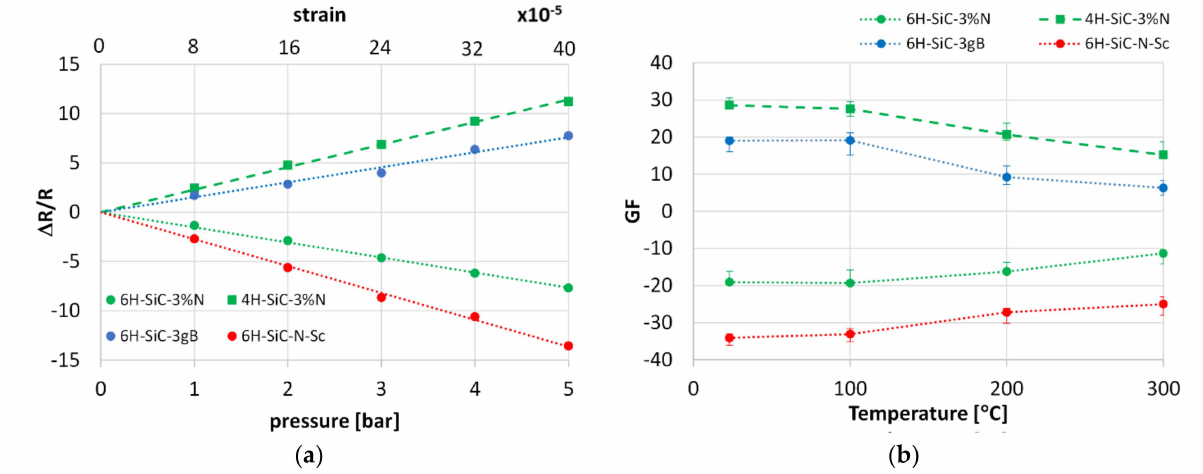
Figure 14. The effect of pressure on the sensor resistivity change ( a ) and Gauge Factor of sensors as a function of temperature ( b